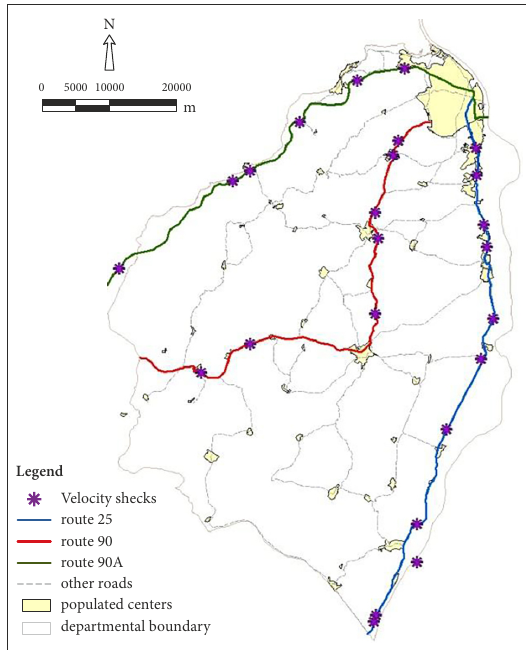
Figure 3. Speed checks on the highways of the Atlantic Department